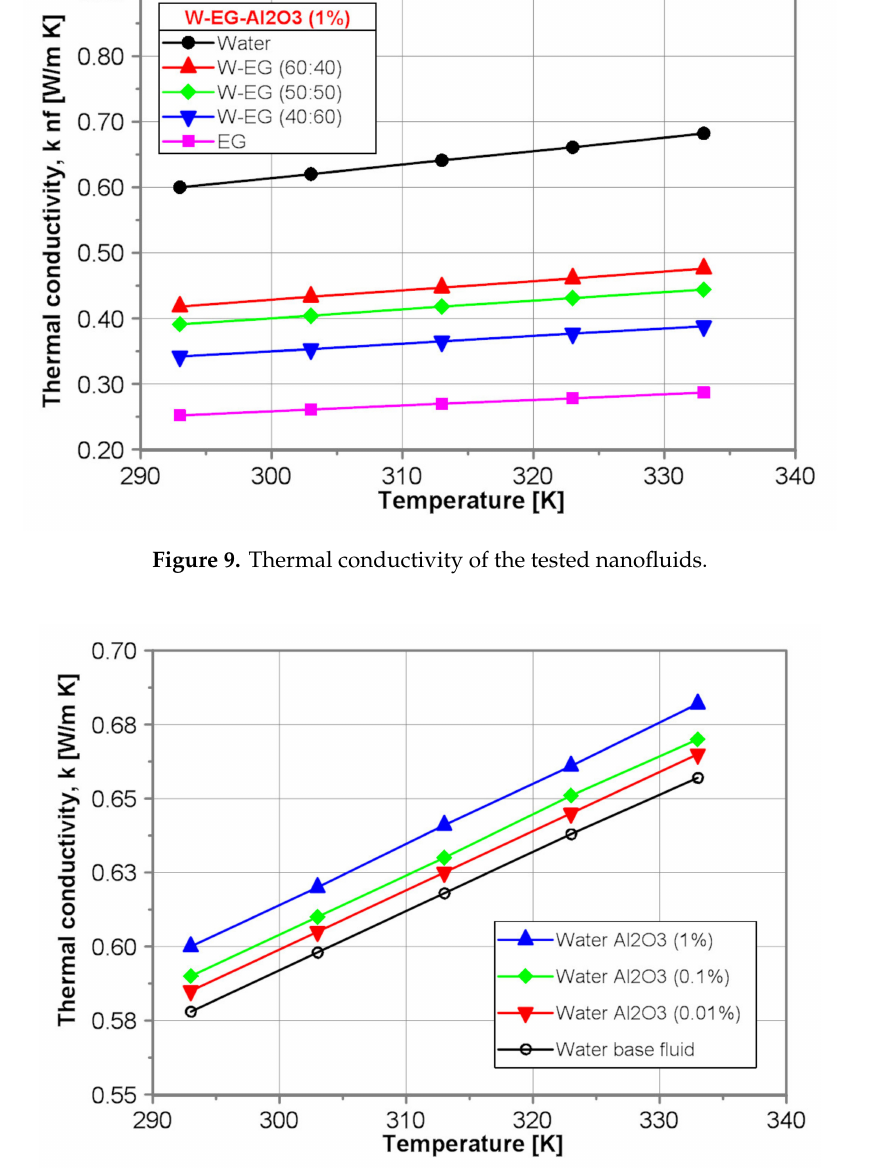
Figure 10. Dynamic viscosity of the tested EG-Al 2 O 3